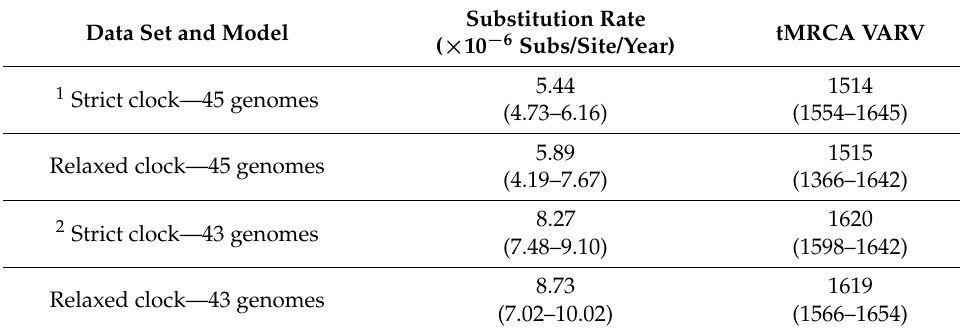
Table 1. Results of the Bayesian analysis of the evolutionary history of variola virus